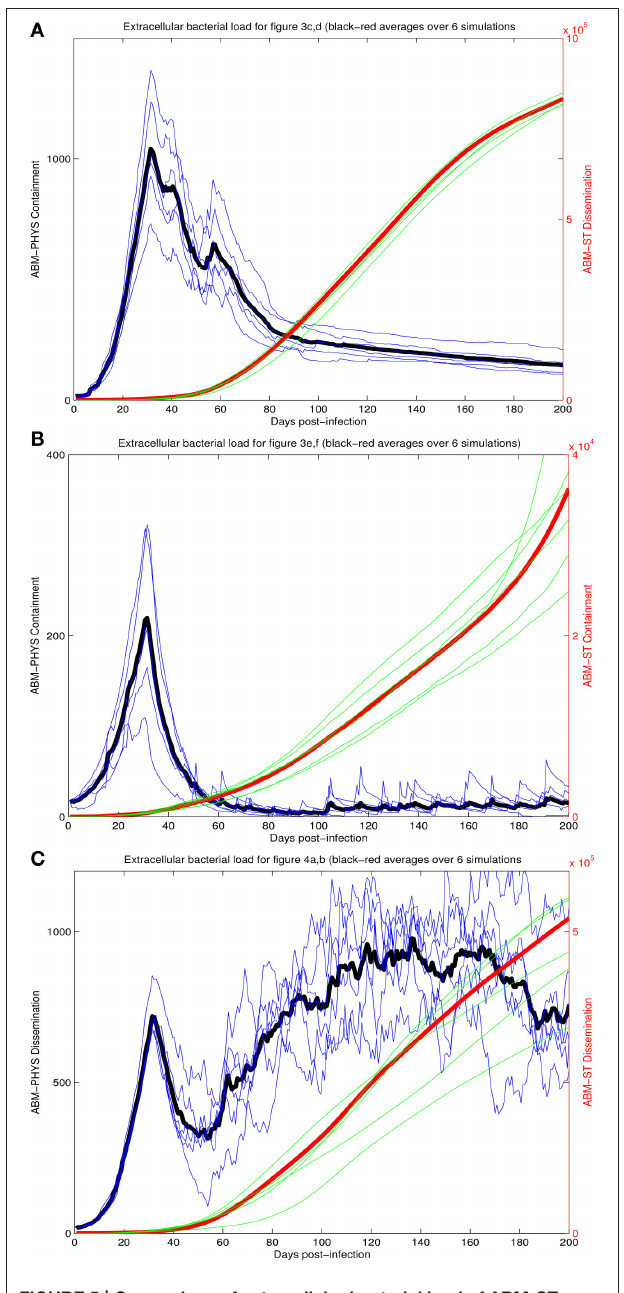
FIGURE 5 | Comparison of extracellular bacterial load of ABM-ST vs. ABM-PHYS model for each of the three scenarios in Figure 3: transient containment (A, Figures 3A–D); containment (B, Figures 3E,F) and dissemination (C, Figures 3G,H). Results represent an average of six simulations in all scenarios except the transient containment scenario for ABM-ST, which has five simulations. Bacterial loads for containment in